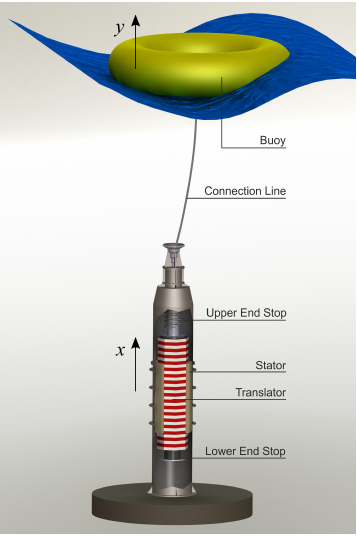
Figure 1. Illustration of the Uppsala wave energy converter (WEC). The linear generator at the seabed is connected via a steel wire to a so-called donut shaped buoy. Note that the buoy used for the